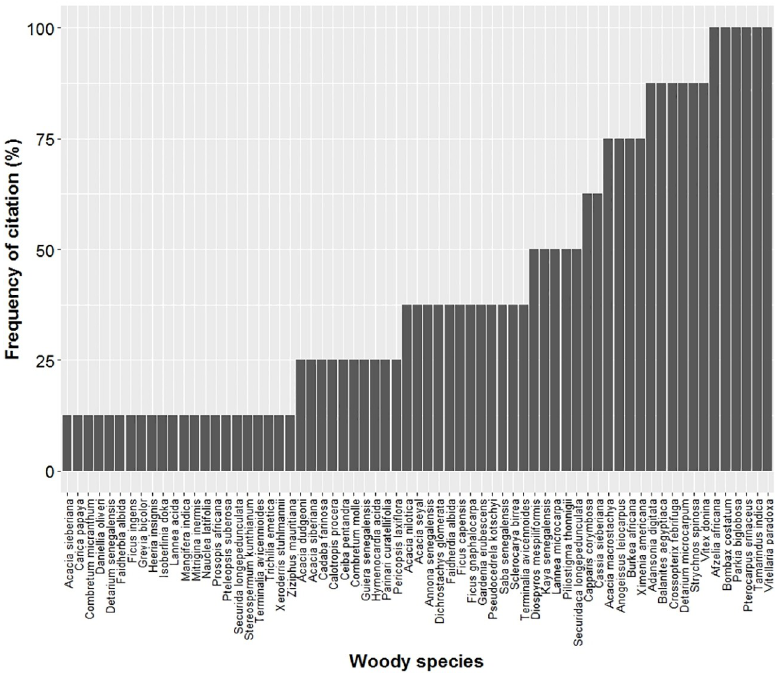
Fig 2. Frequency curve of species across the study villages (Cassou, Dao, Kou and Vrassan) in Ziro province of Burkina Faso.